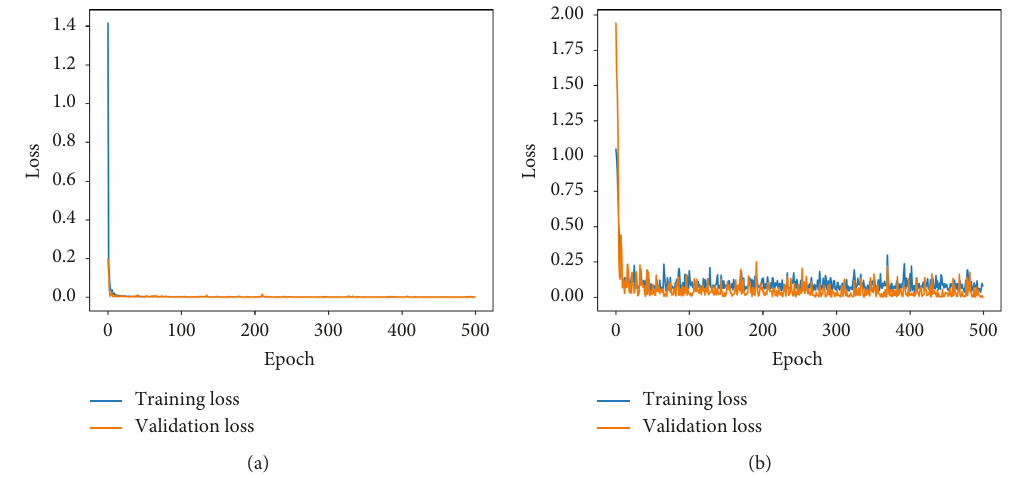
Figure 14: The training processes of the proposed models on UCI seismic bumps: (a) DCTCNN; (b) CNN-LSTM.